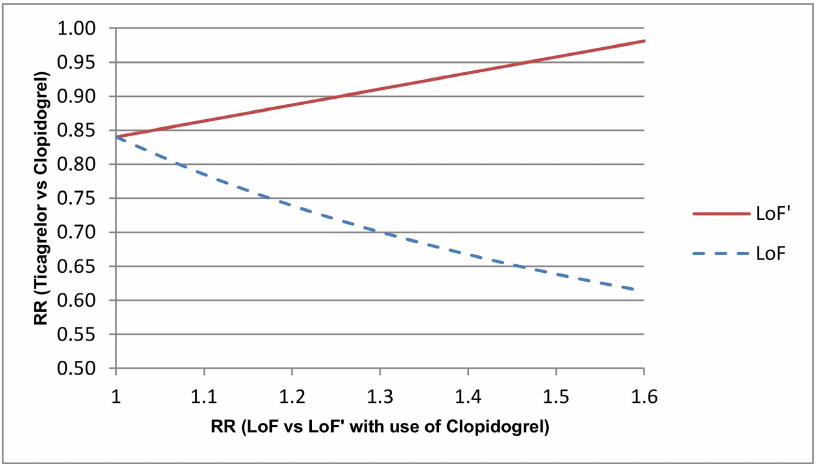
Figure 2. One way deterministic sensitivity analysis for indirect estimates of treatment effect. The indirect estimates of the treatment effect (relative risk for comparison of ticagrelor and clopidogrel) for subgroups based on cytochrome P450 2C19 (CYP2C19) genotype are displayed as a function of the size of the association study estimate. LoF=subgroup with a CYP2C19 loss-of-function allele, LoF 9 =subgroup without a CYP2C19 loss-of-function